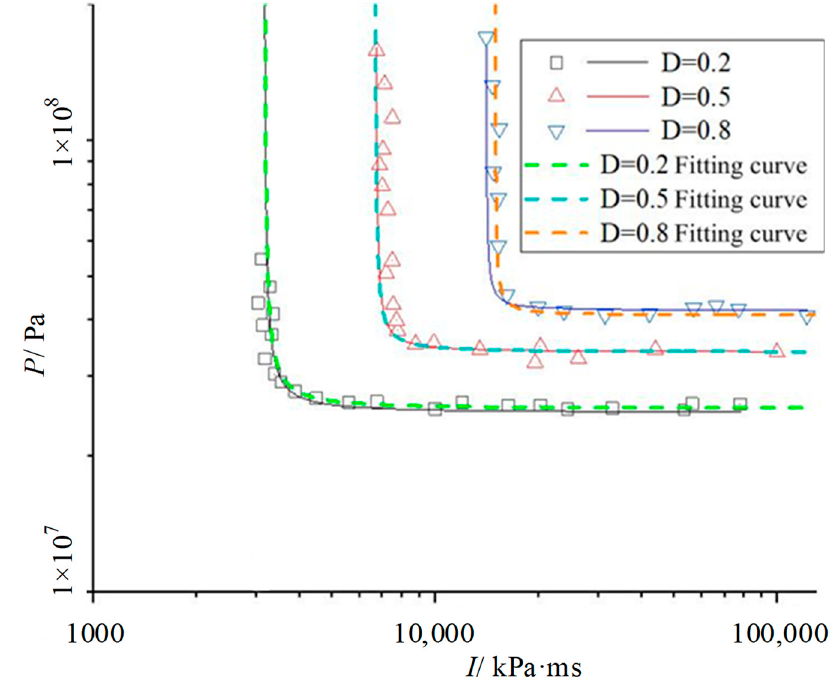
Figure 12. P - I curves with k = Figure 12. P-I curves with k = 10.